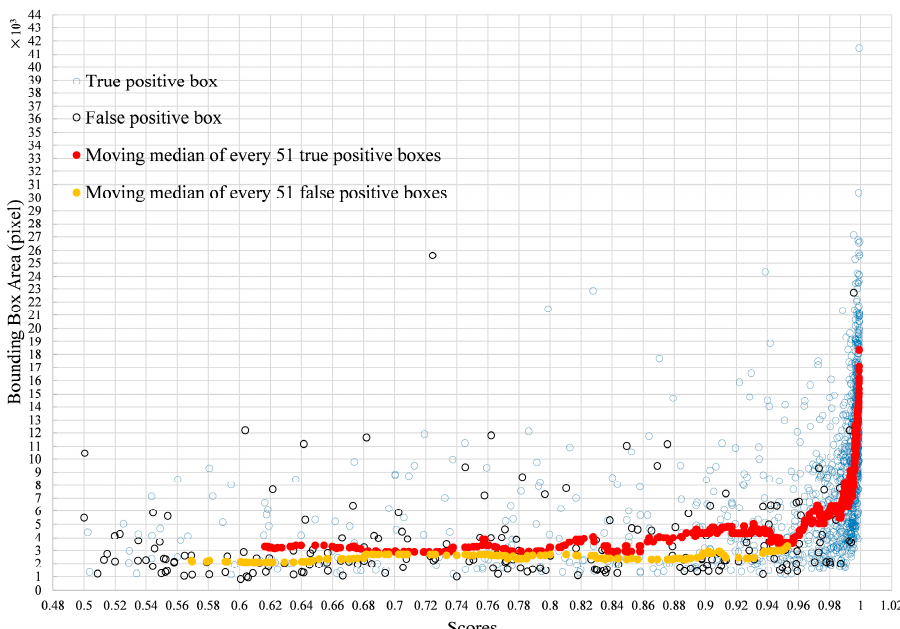
Figure 12. Area distribution of detected true positive boxes and false positive boxes with the scores, and their moving median value with the